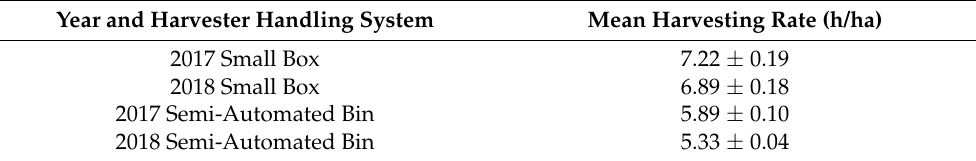
Table 5. Mean harvest rates for both harvester handling systems for 2017 and